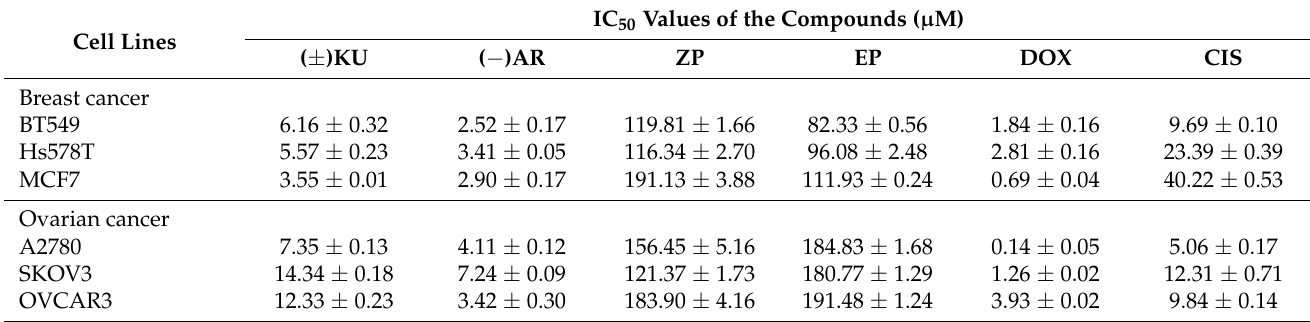
Table 1. IC 50 values of ( ± )KU, ARIs and chemotherapeutic drugs against breast and ovarian cancer cells. IC 50 Values of the Compounds ( µ M) Cell Lines